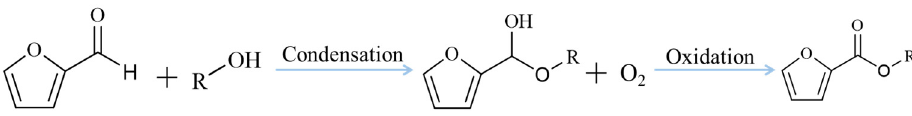
Figure 2. Mechanism diagram of the oxidative esterification of furfural with aliphatic alcohols.